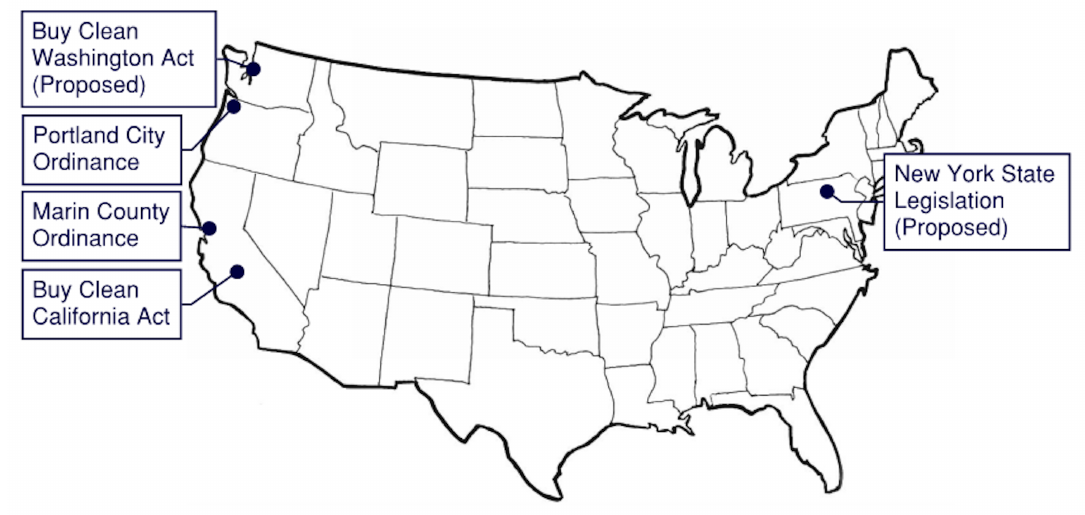
Figure 1. Local government and state initiatives related to sustainability of construction